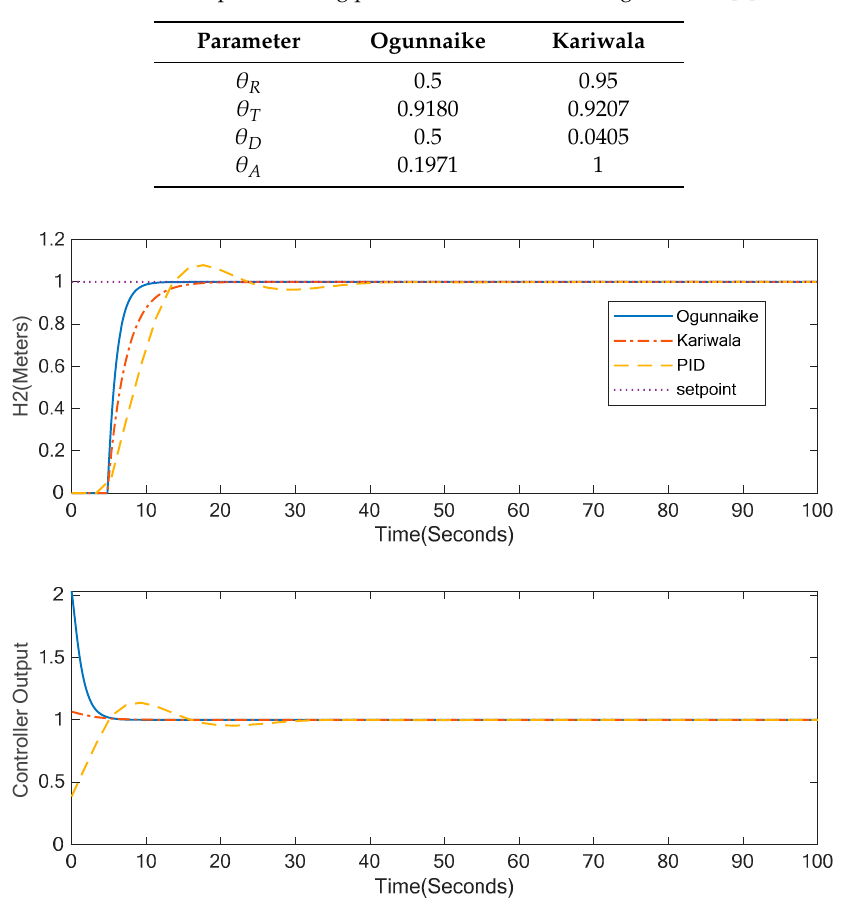
Table 4. Example 1: Tuning parameters with two tuning methods [4].